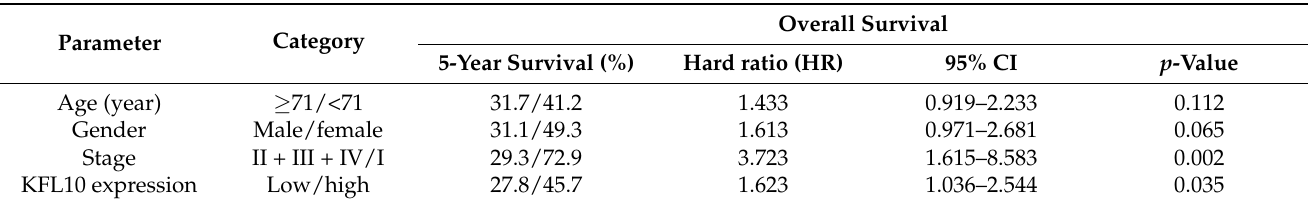
Table 2. Univariate analysis of the influence of various parameters on overall survival in 121 gastric cancer patients.